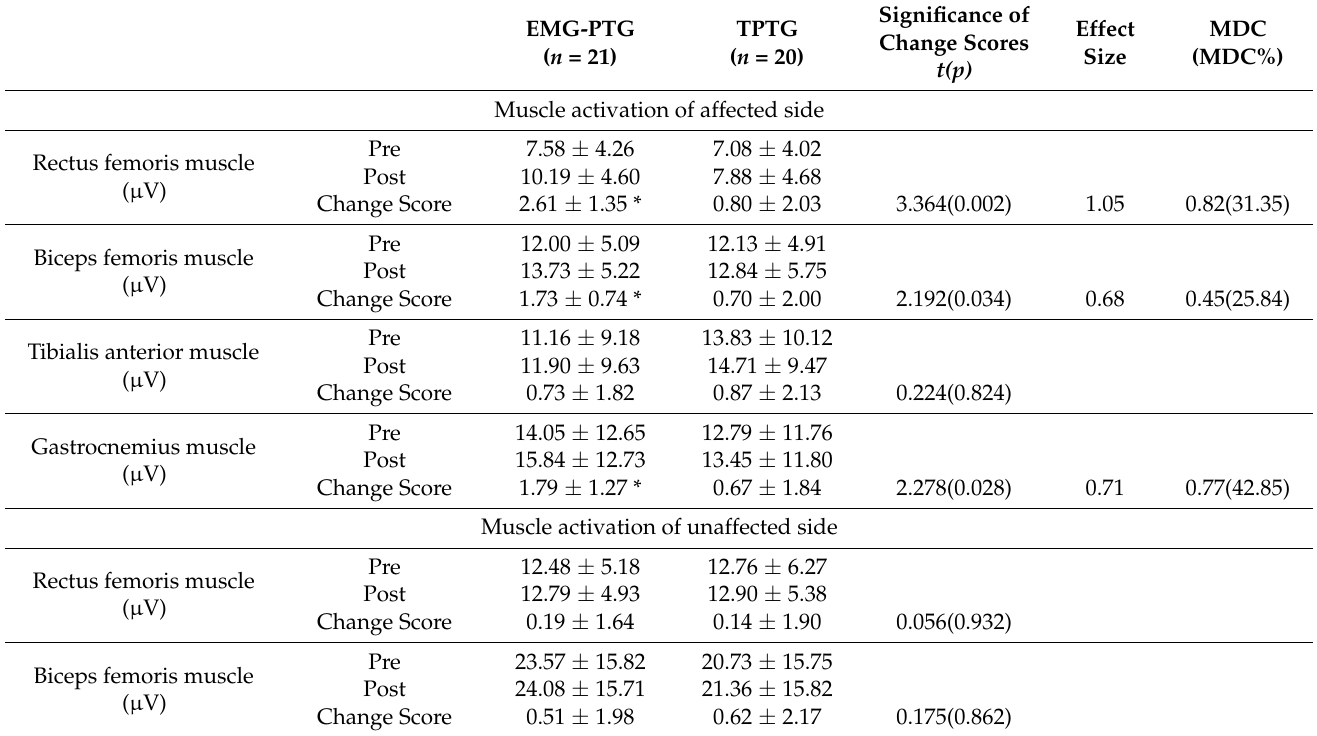
Table 2. Changes of muscle